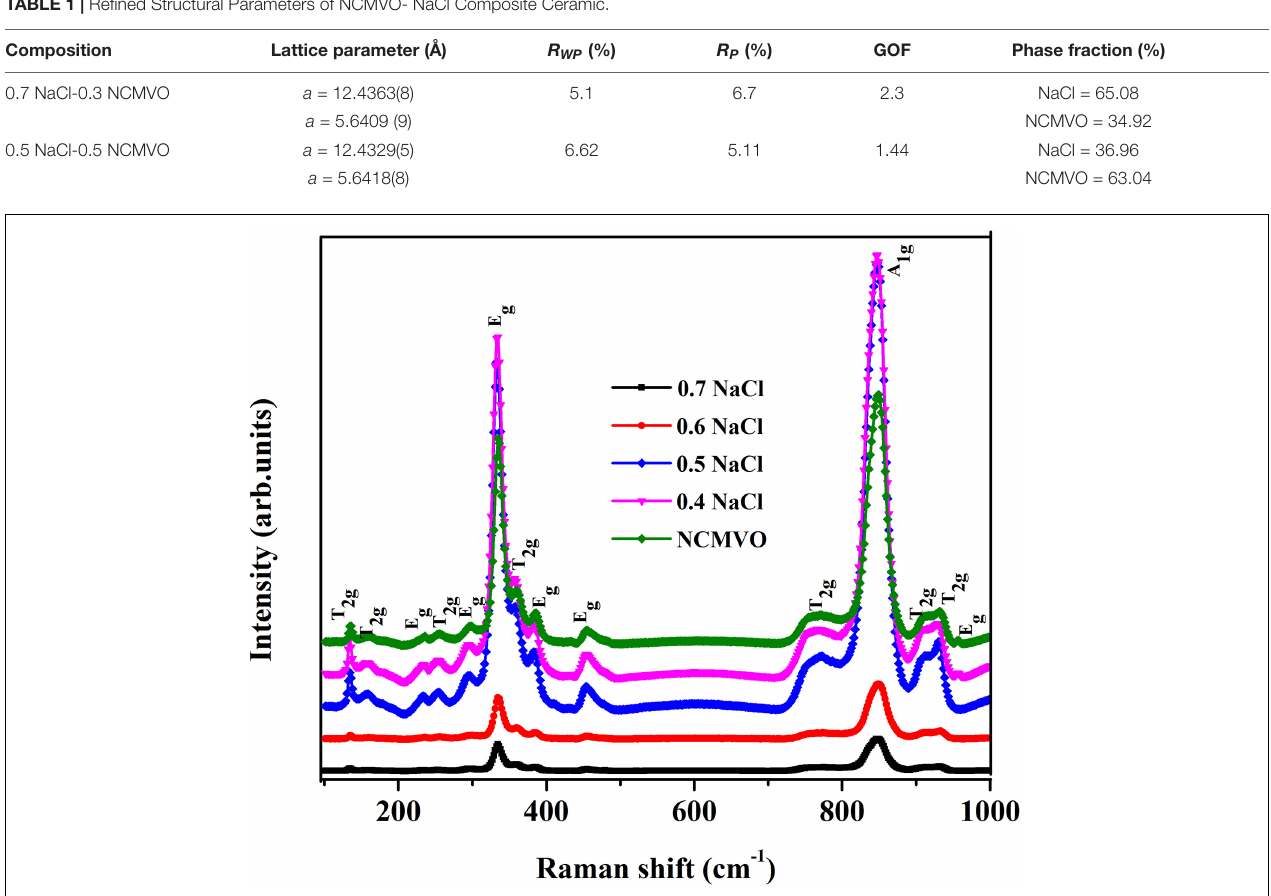
FIGURE 4 | The Raman spectra of NCMVO and (1 – x ) NCMVO-xNaCl ( x = 0.4, 0.5, 0.6, and 0.7) composites.